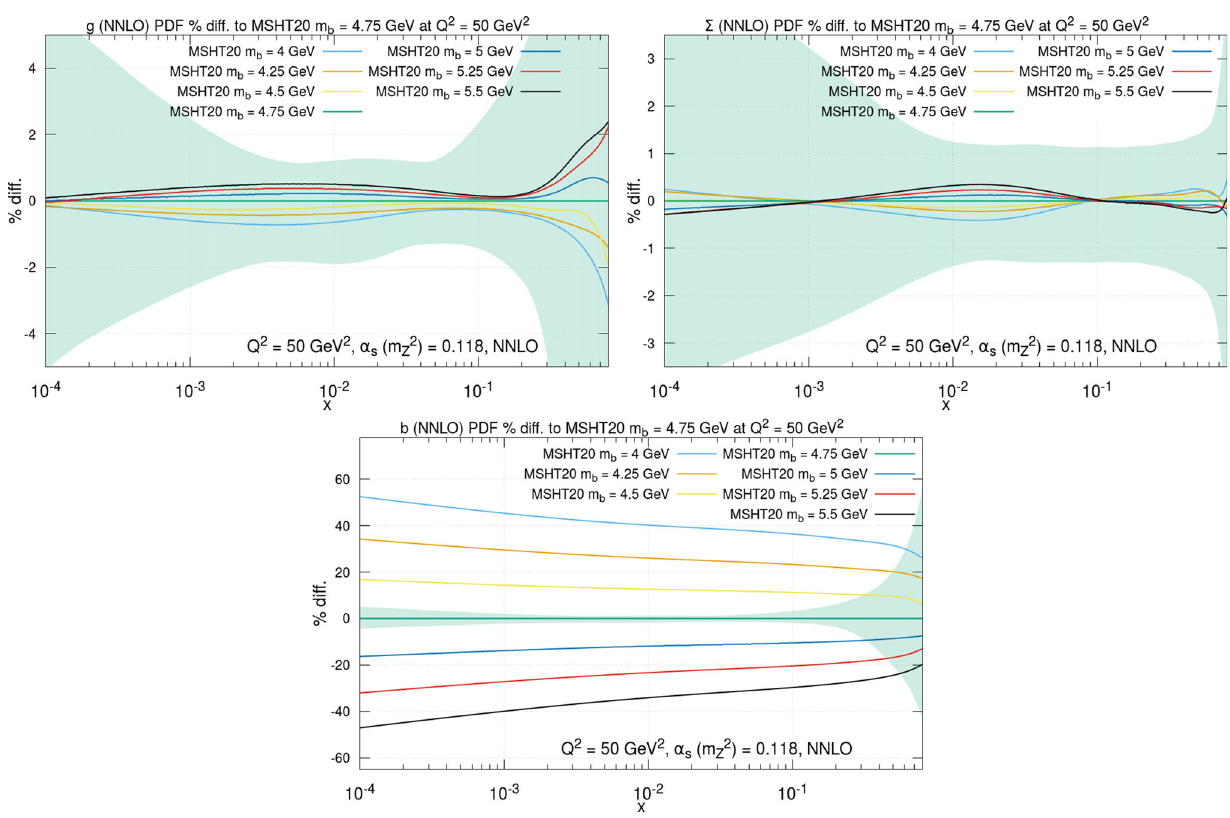
Fig. 25 The m b dependence of the gluon, light-quark singlet and bottom distributions at NNLO for Q 2 = 50 GeV 2 , compared to the standard MSHT20 distributions with m c = 1 . 4 GeV and m b = 4 . 75